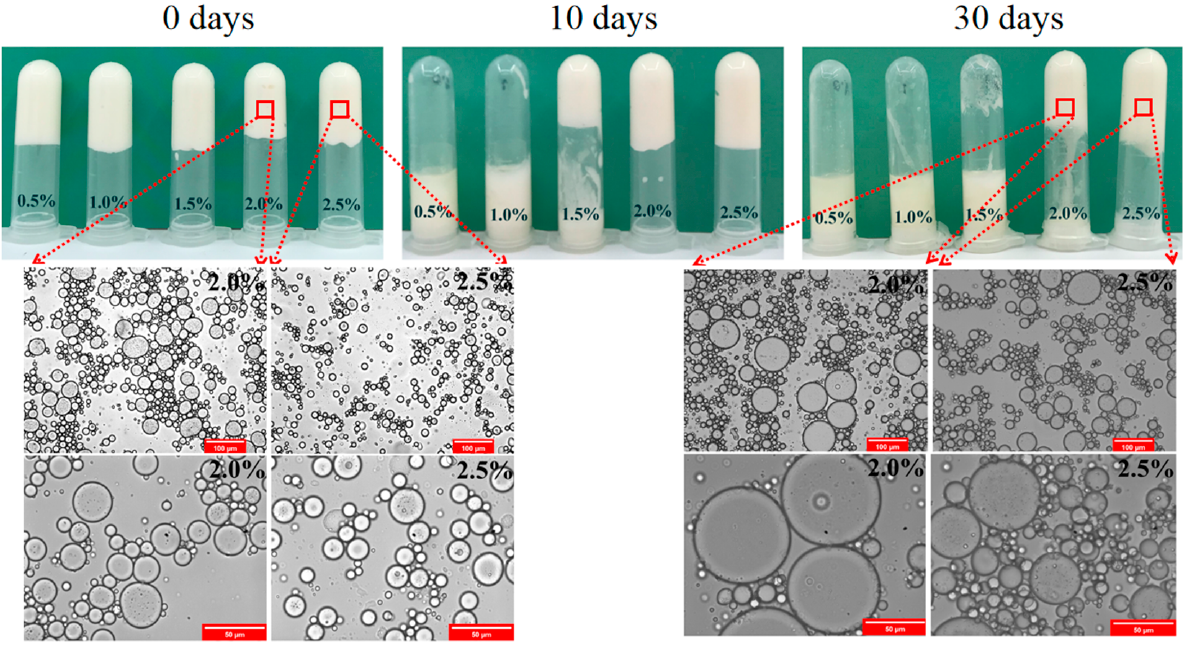
Figure 7. Visual appearance (W 2 : 0.5 wt%, 1.0 wt%, 1.5 wt%, 2.0 wt% and 2.5 wt%) and optical micrographs (W 2 : 2.0 wt% and 2.5 wt%) of W/O/W emulgels with different concentration of SSPs during storage at 4 °C for 0, 10, and 30 days. Scale bars, 100 μ m and 50 μ m, respectively.